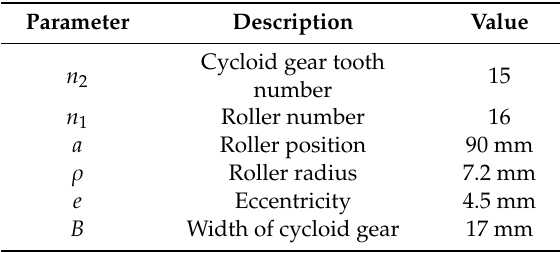
Table 2. Basic design parameters of the example cycloid gear pair.